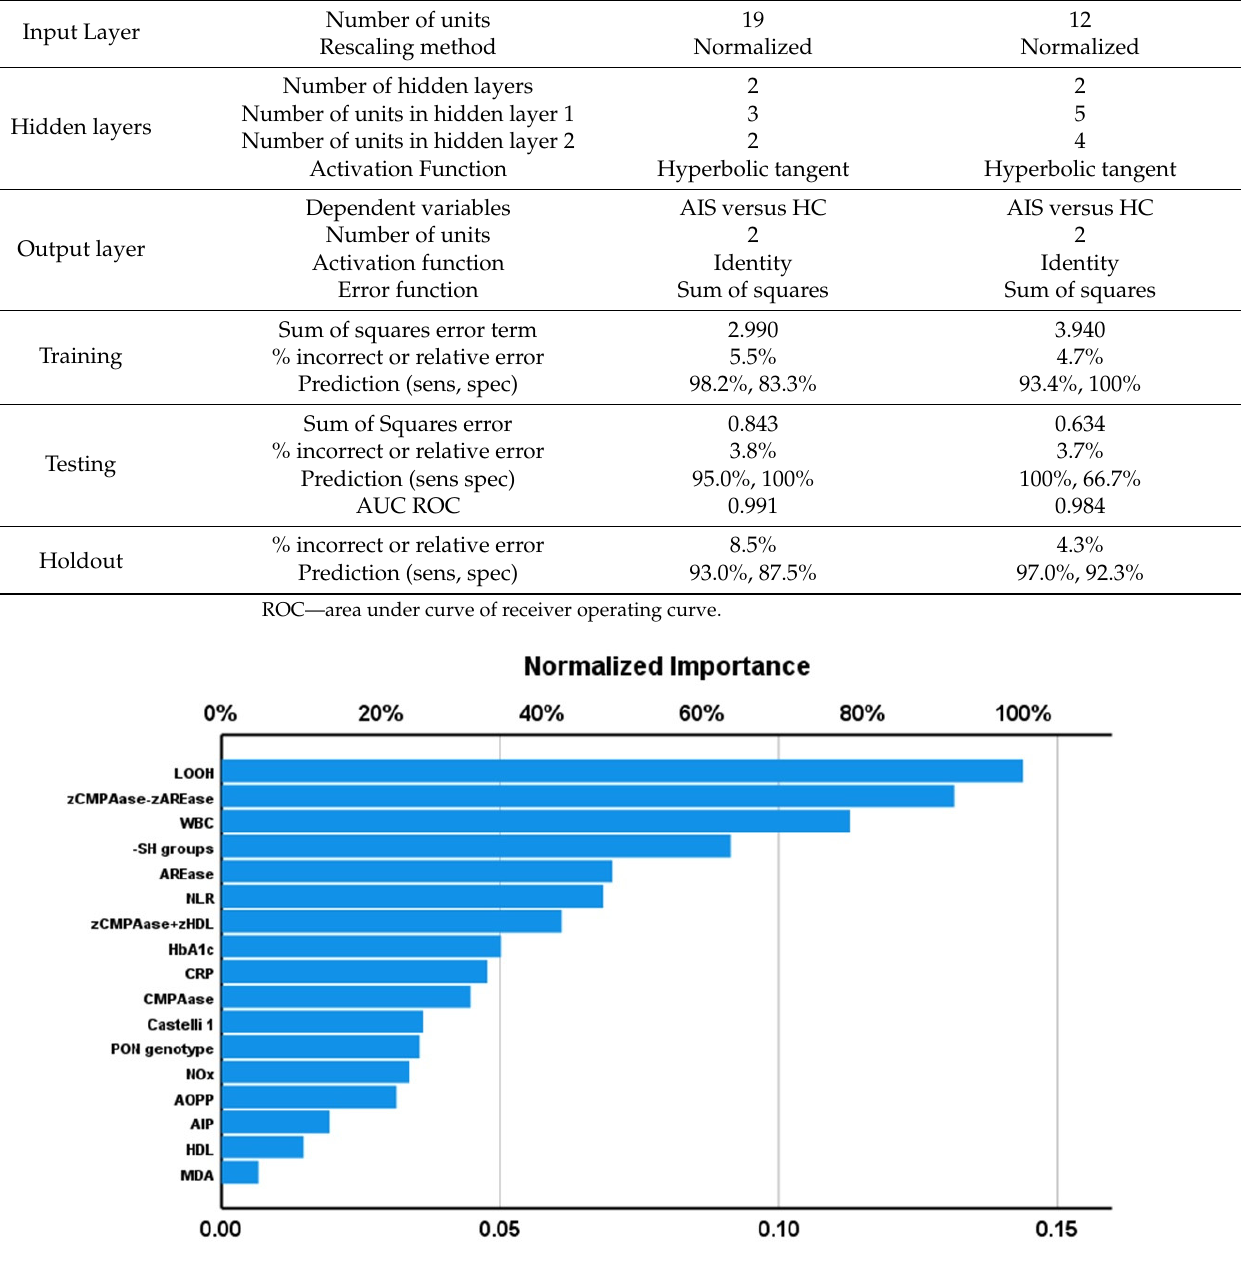
Figure 1. Importance chart of a neural network analysis with acute ischemic stroke (AIS) versus